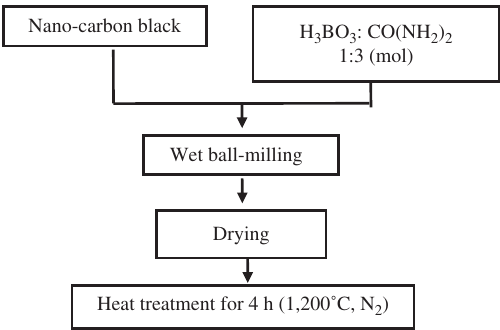
Figure 1: Flowchart of fabrication process of BN-coated